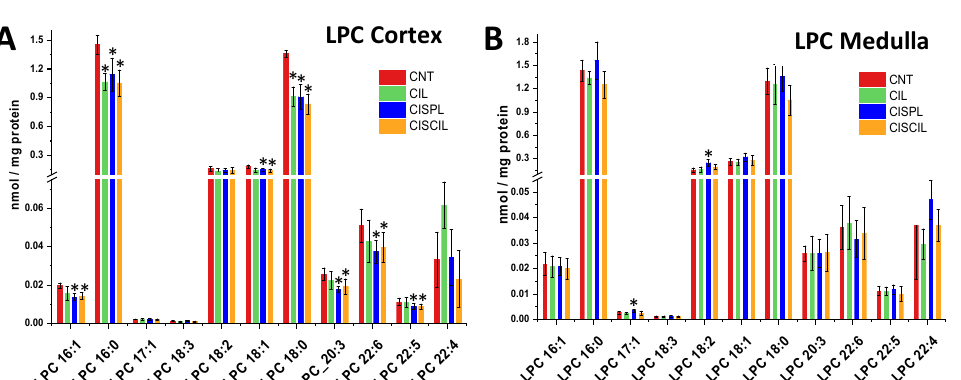
Figure 7. Lysophosphatidylcholine (LPC) species found in the renal ( A ) cortex and ( B ) medulla in CNT, CIL, CISPL, and CISCIL groups. * p < 0.05 vs. CNT. Data are presented as the mean ± sd; n = 6 animals per group.